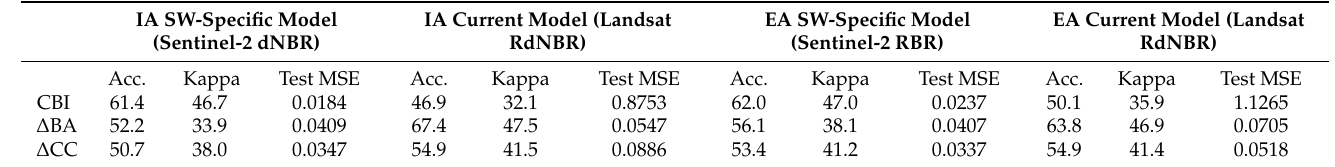
Table 5. Comparison of our final SW models predicting CBI, ∆ BA, and ∆ CC (percent accuracy, Kappa, and test MSE) to models currently used in RAVG burn severity and forest change products at the time of this writing